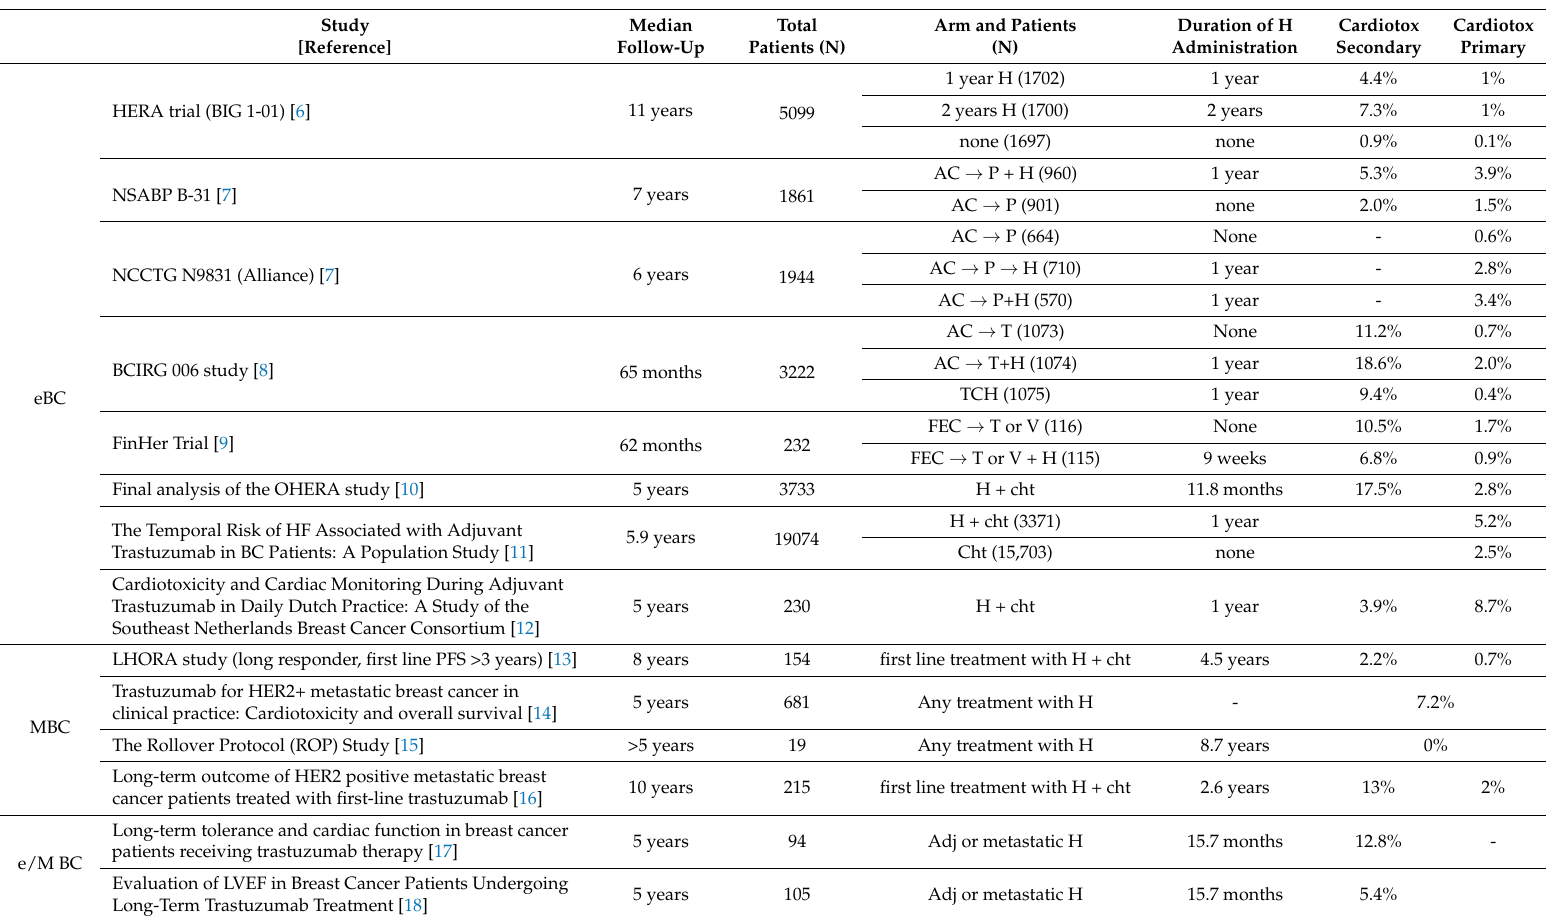
Table 1. Studies included for long-term